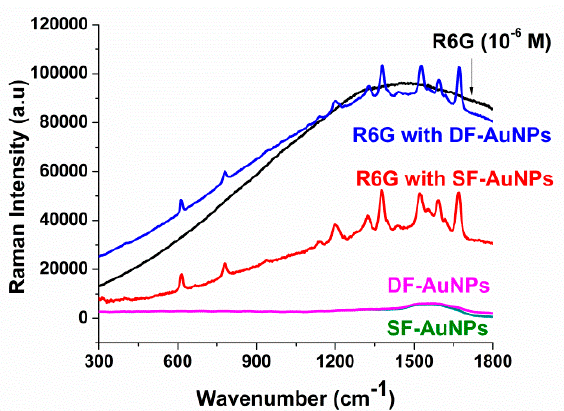
Figure 5. SRES spectra: black (R6G only), blue (R6G on DF-AuNPs), red (R6G on SF-AuNPs), pink (DF-AuNPs), and green line (SF-AuNPs).